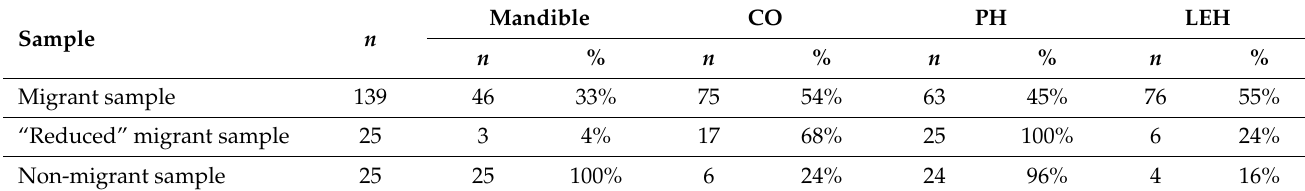
Figure 1. Multiple lines of linear enamel hypoplasia on a maxillary molar of a migrant. Table 2. Frequencies of cribra orbitalia (CO), porotic hyperostosis (PH), and linear enamel hypoplasia (LEH) in the samples.